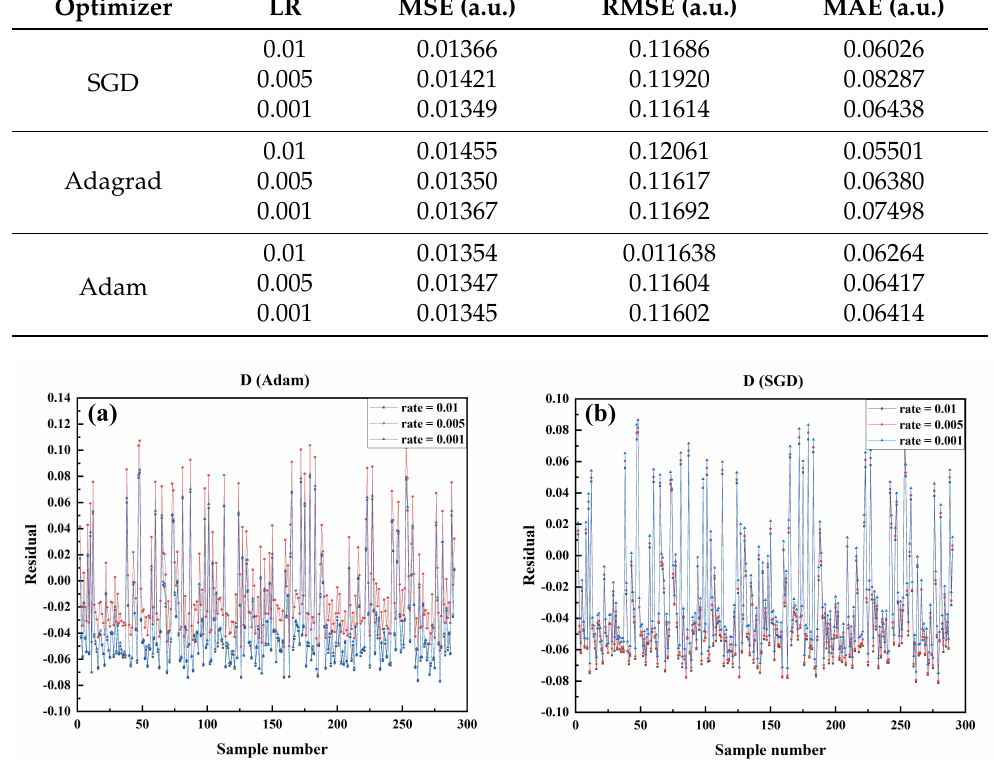
Figure 11. Comparison of the residual between the predicted value and the actual value of D in the test data set of the model trained by each algorithm under different learning rates in SGD optimizer and Adam optimizer. ( a ) SGD optimizer, LR: 0.01, 0.001, 0.005 ( b ) Adam optimizer, LR: 0.01, 0.001,